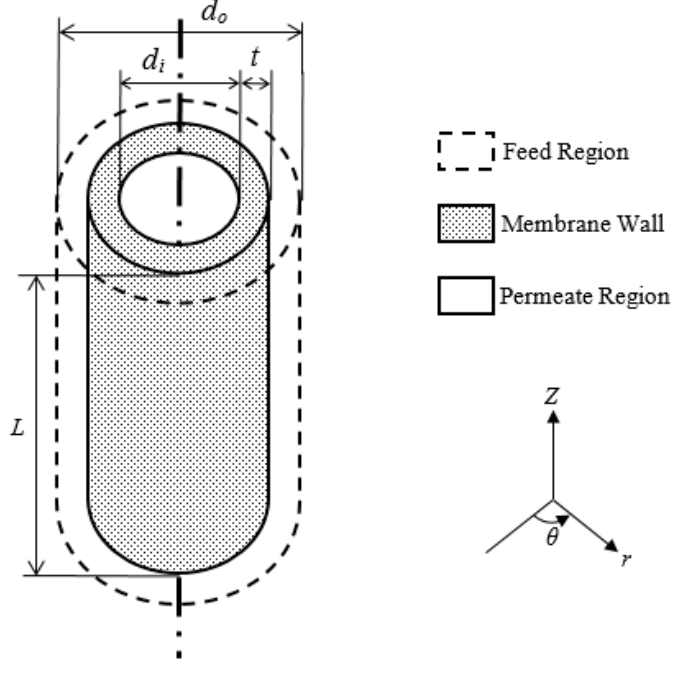
Figure 3. Illustration of 3-dimensional hollow fibre model to be used in numerical domain.